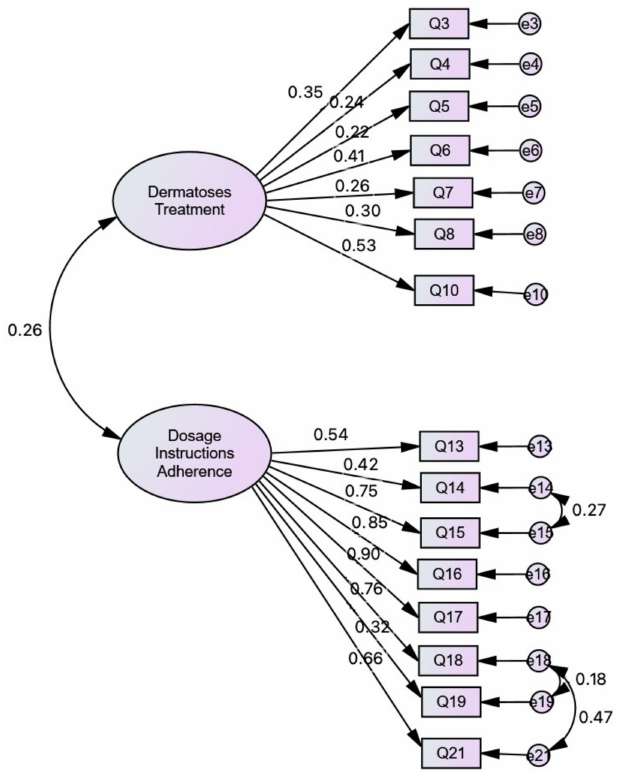
Figure 1. Model Fit of the Pharmacists’ Knowledge Questionnaire in a sample of pharmacists whose workplace is the community pharmacy: χ 2 = 154.008; df = 86; χ 2 / df = 1.791; CFI = 0.930; TLI = 0.915; RMSEA = 0.059; PCLOSE =